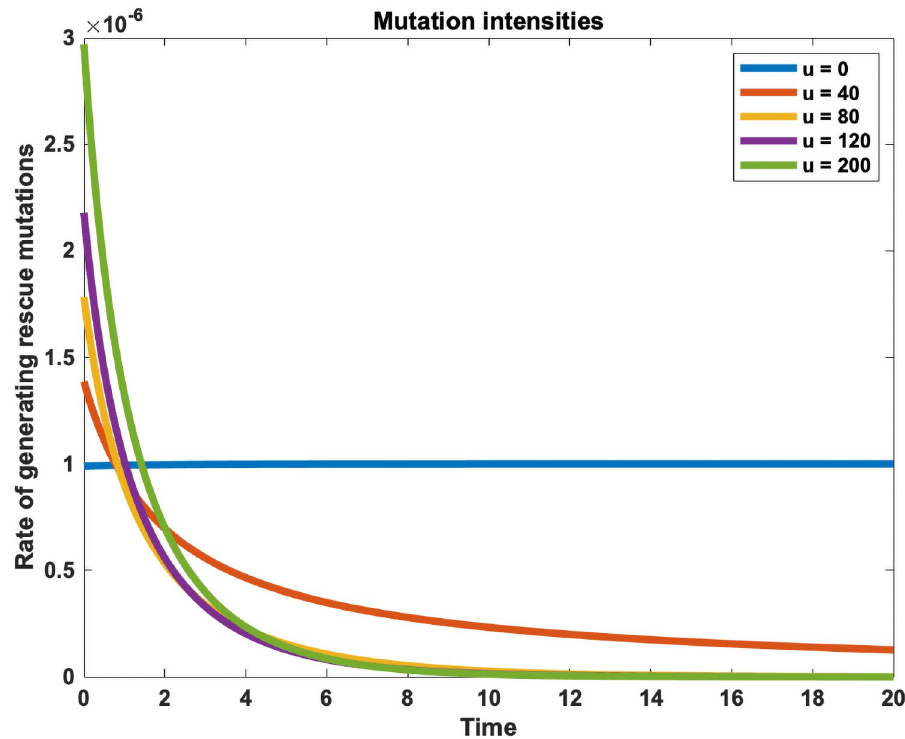
Fig 2. Time-dependent mutation rate profiles. Each treatment strategy u ( t ) leads to a characteristic mutation intensity profile S ( t , u ( t )) μ ( u ( t )),which gives the rate of gaining a rescue mutant as a function of time. If no treatment is administered ( u ( t ) = 0), the population grows to its carrying capacity and generates rescue mutations at a constant baseline mutation rate (blue). A dose-dependent mutation rate introduces a trade-off, where treatment can be used to decrease the population size only at the expense of simultaneously increasing the mutation rate. This creates a sharp mutation peak at the beginning, when treatment is applied to a large population size. The optimal treatment strategy, which minimises the probability of evolutionary rescue, exploits this trade-off by balancing the early mutational peak such that the area under intensity profile is minimised. The plotted intensity profiles were generated using the constant doses given in the legend and the same model and parameters as given in the Methods section (Eq 7 and Table